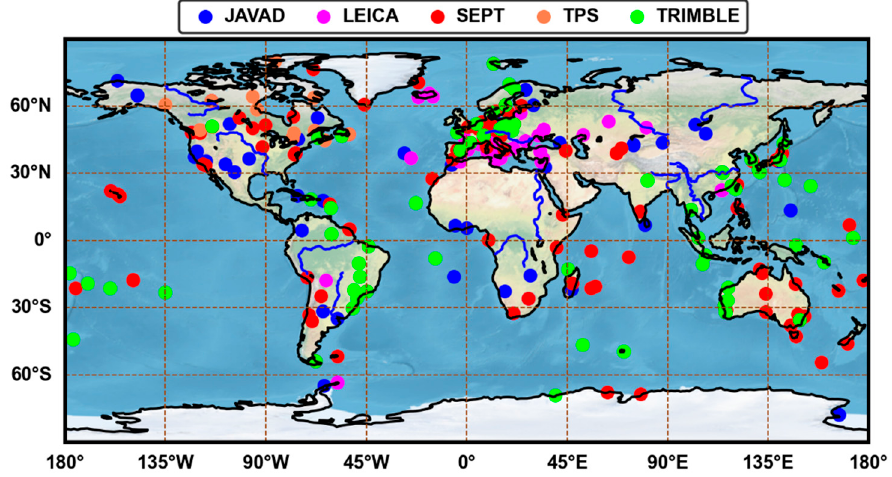
Figure 1. Distributions of stations used for the SDB calibration.